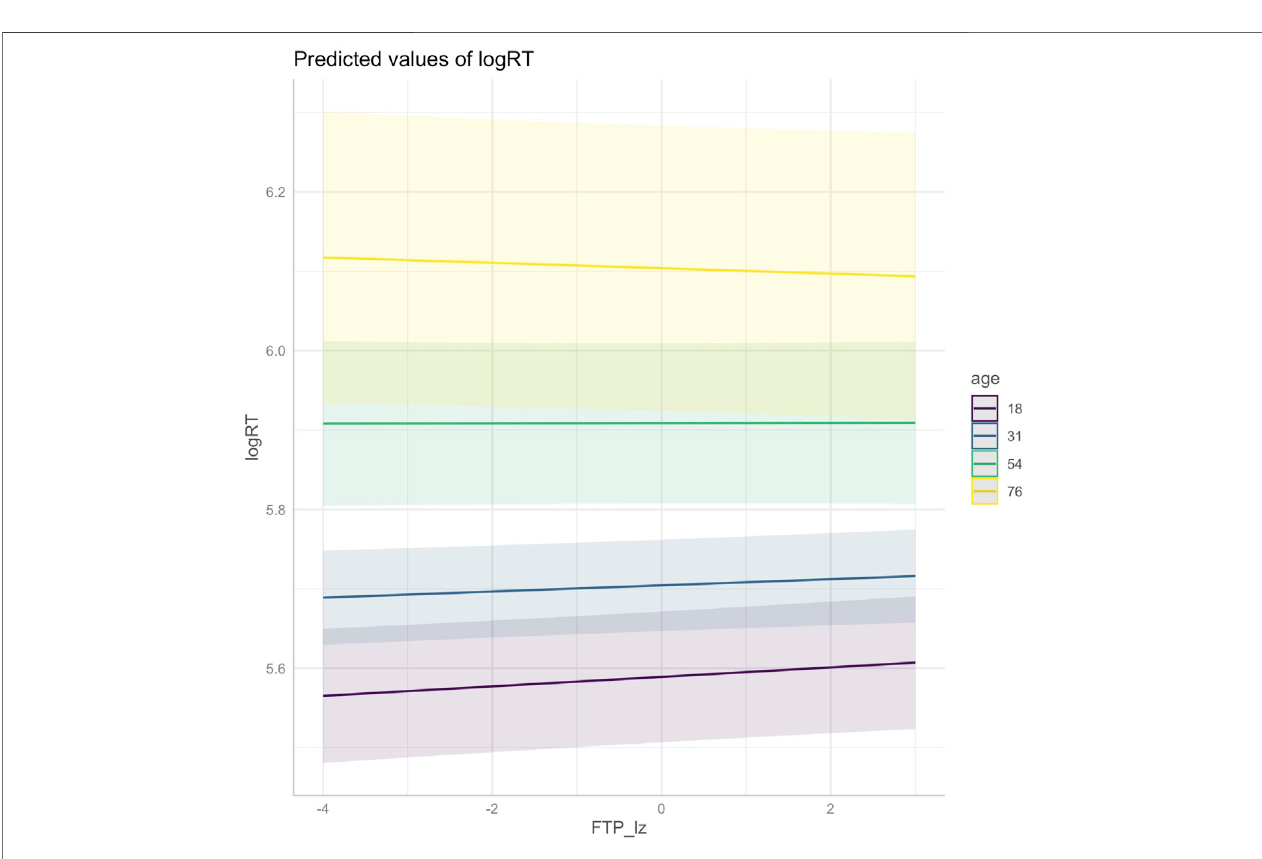
Frontiers in Communication |